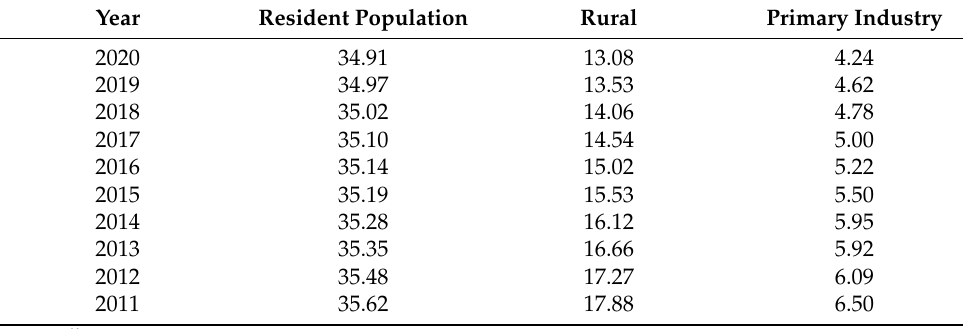
Figure 1. Map showing the geographical locations of 11 administrative cities in Shanxi Province, north China, where cattle blood samples were collected. Sky blue represents north Shanxi Province; grass green represents central Shanxi Province; magenta represents south Shanxi Province. Red pentagram represents Beijing city, the capital of China. Table 1. Population and employment statistics of Shanxi Province.